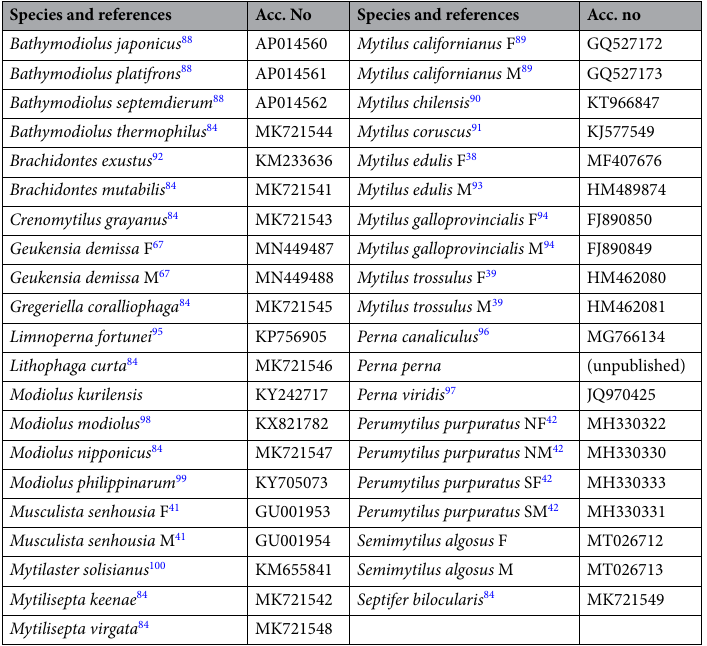
Table 2. List of mitogenomes used in phylogenetic analyses, with species, lineage, accession numbers, and references (wherever